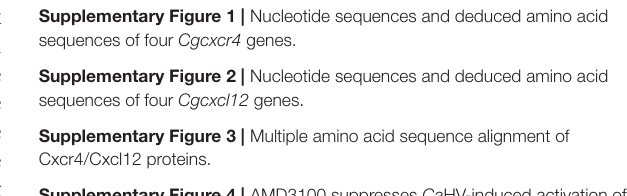
Supplementary Figure 1 | Nucleotide sequences and deduced amino acid sequences of four Cgcxcr4 genes. Supplementary Figure 2 | Nucleotide sequences and deduced amino acid sequences of four Cgcxcl12 genes. Supplementary Figure 3 | Multiple amino acid sequence alignment of Cxcr4/Cxcl12 proteins. Supplementary Figure 4 | AMD3100 suppresses Ca HV-induced activation of key antiviral genes in gibel carp